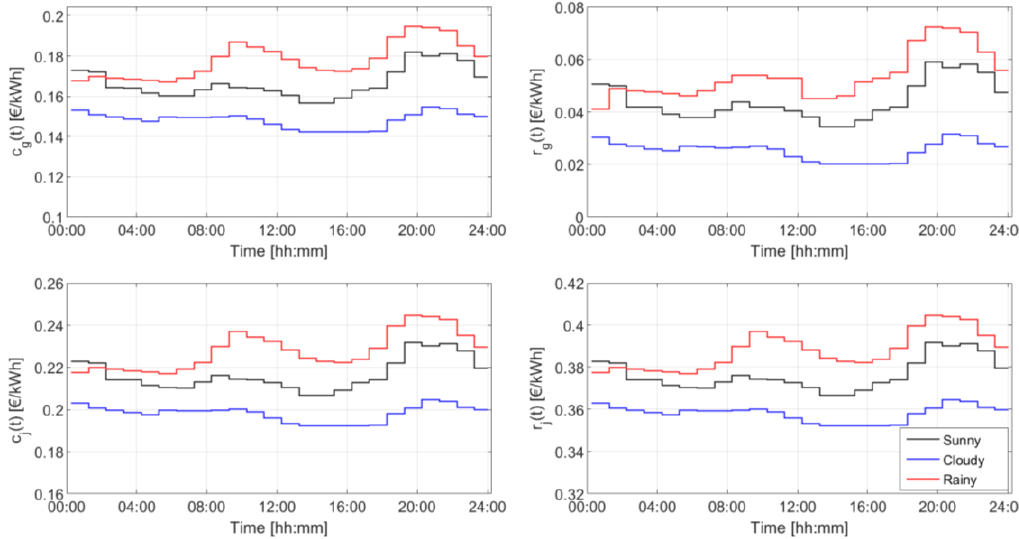
Figure 5. Forecasted EV exploitation patterns on the three different days.